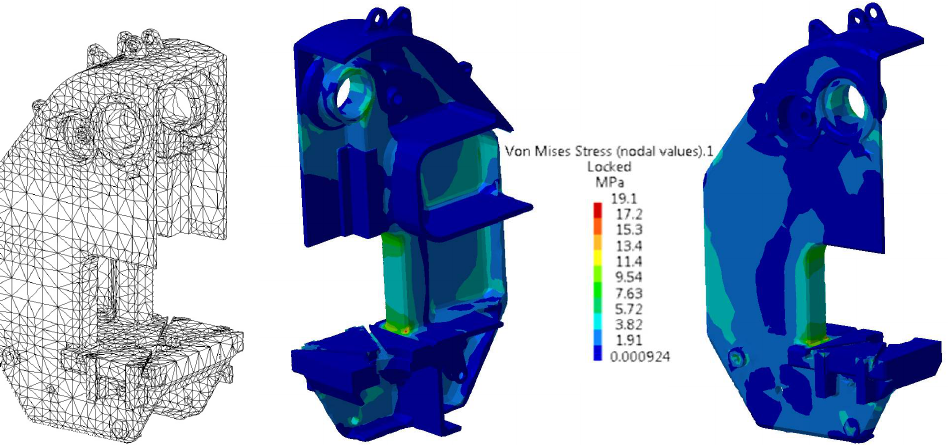
Figure 2. Example of 3D model discretized into tetrahedral elements and stress state for the refer- ence body.